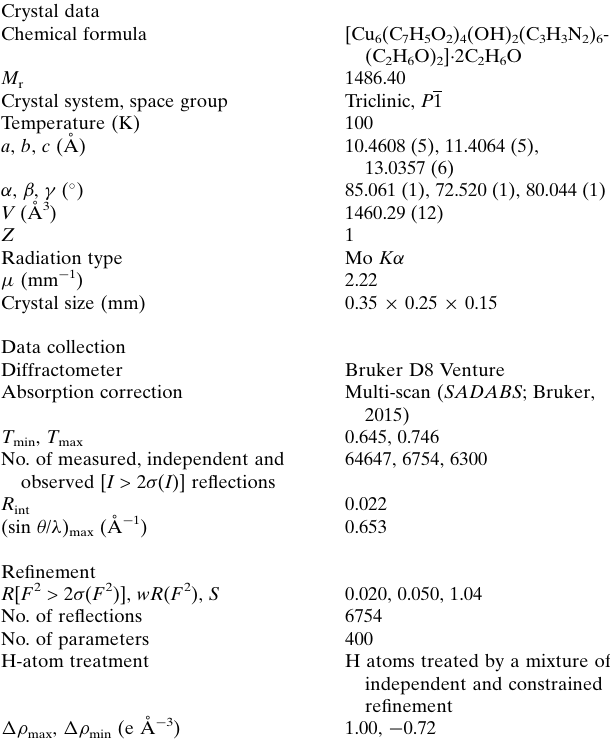
Table 3 Experimental details. Crystal data Chemical